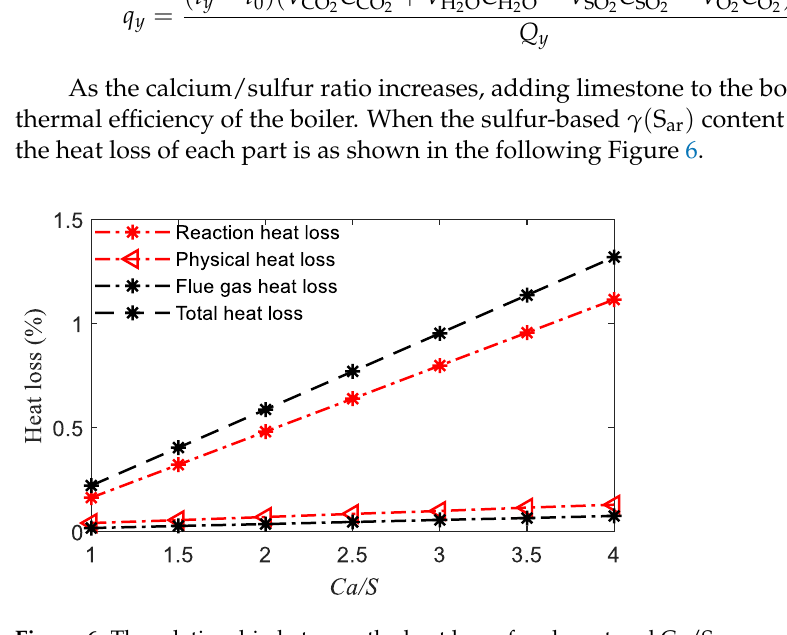
Figure 6. The relationship between the heat loss of each part and